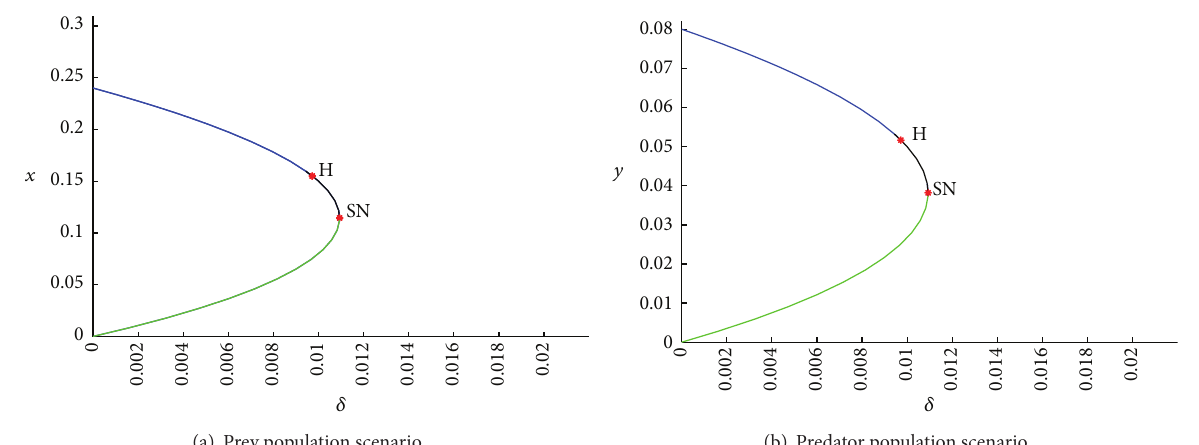
Figure 5: A saddle-node bifurcation of system (7) at 𝛿 = 0.010932 (mark as SN), for 𝑔 = 1.44 , 𝛼 = 0.8 , 𝛼 1 = 0.4 , and 𝛽 = 0.3 . A Hopf bifurcation also occurs.